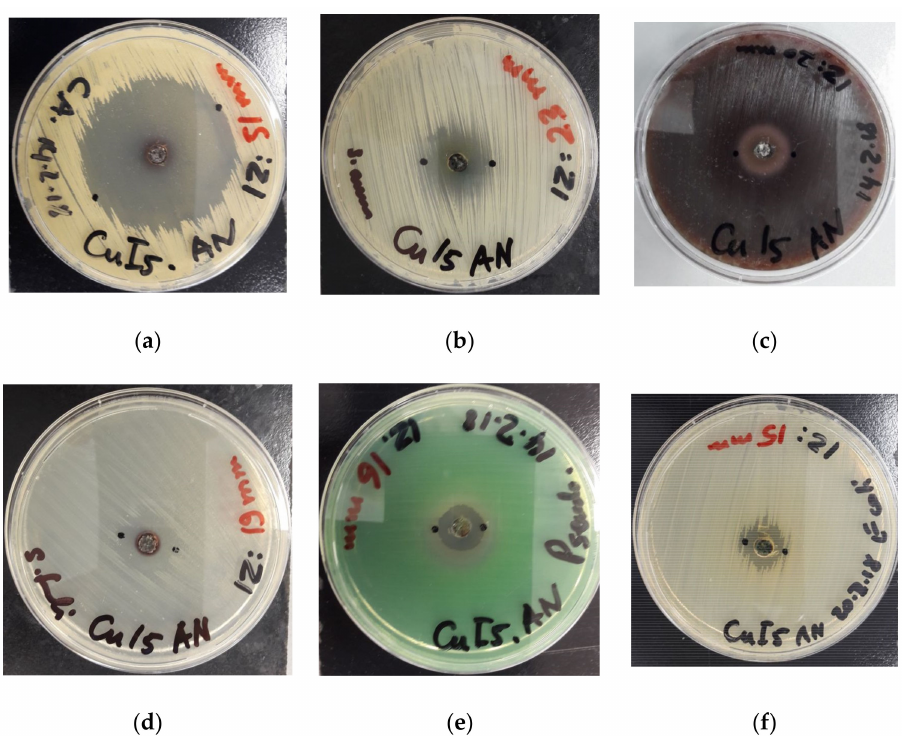
Figure 7. Agar well methods of [Cu(12-crown-4) 5 (H 2 O) 6 ]I 6 · 2I 2 . From left to right: [Cu(12-crown- 4) 5 (H 2 O) 6 ]I 6 · 2I 2 against ( a ) C. albicans WDCM 00054 ; ( b ) S. aureus ATCC 25932; ( c ) S. pyogenes ATCC 19615; ( d ) E. faecalis ATCC 29212 ; ( e ) P. aeruginosa WDCM 00026 ; ( f ) E. coli WDCM 00013 . The inhibitory action of [Cu(12-crown-4) 5 (H 2 O) 6 ]I 6 · 2I 2 shows a general increasing